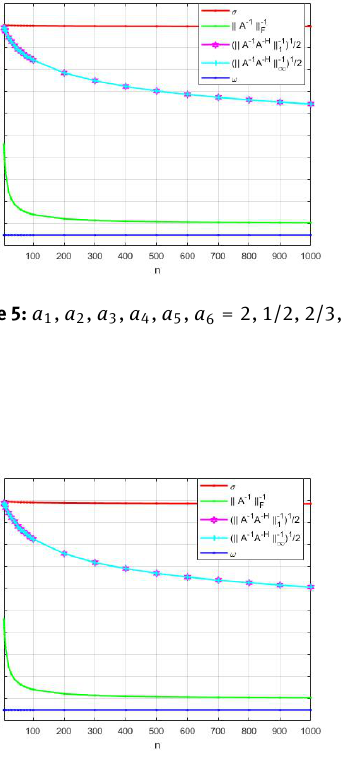
Figure 8: a 1 , a 2 , a 3 , a 4 , a 5 , a 6 , a 7 , a 8 , a 9 = 20/7, 2/7, 4/7, 6/7, 1/7, 5/7, 3/7, 1, 1/7